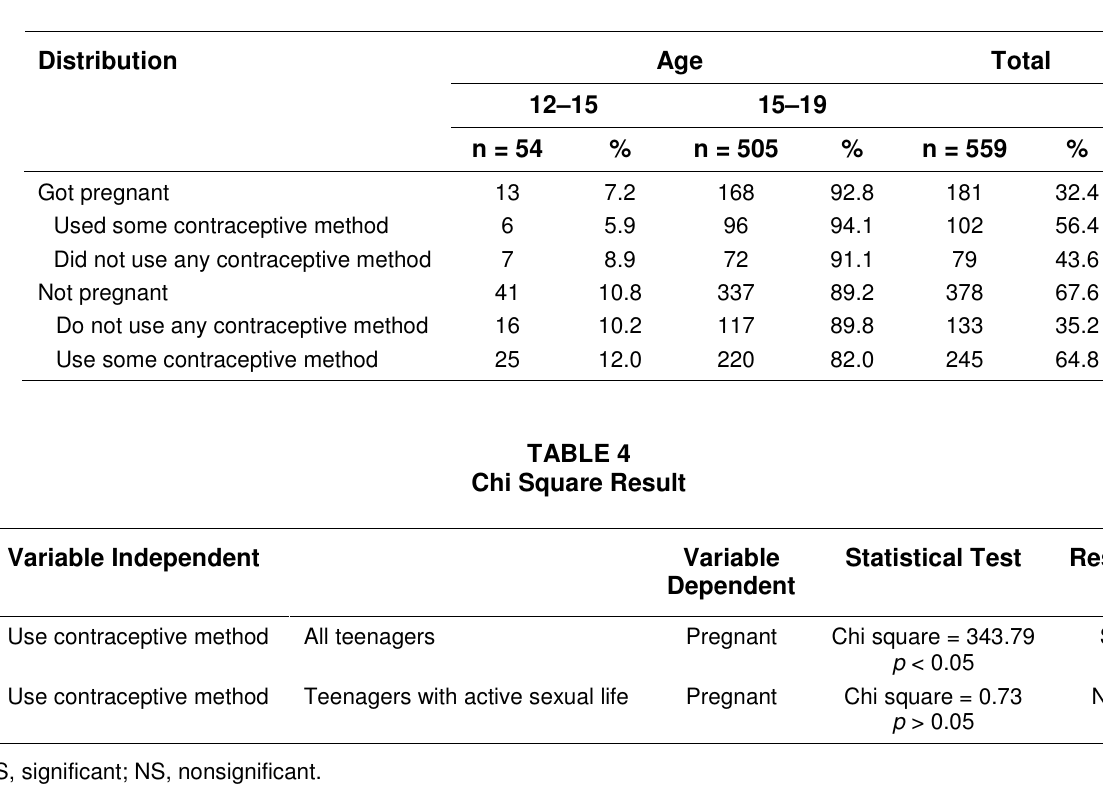
Distribution of the Adolescents According to Use of Contraceptive Methods and